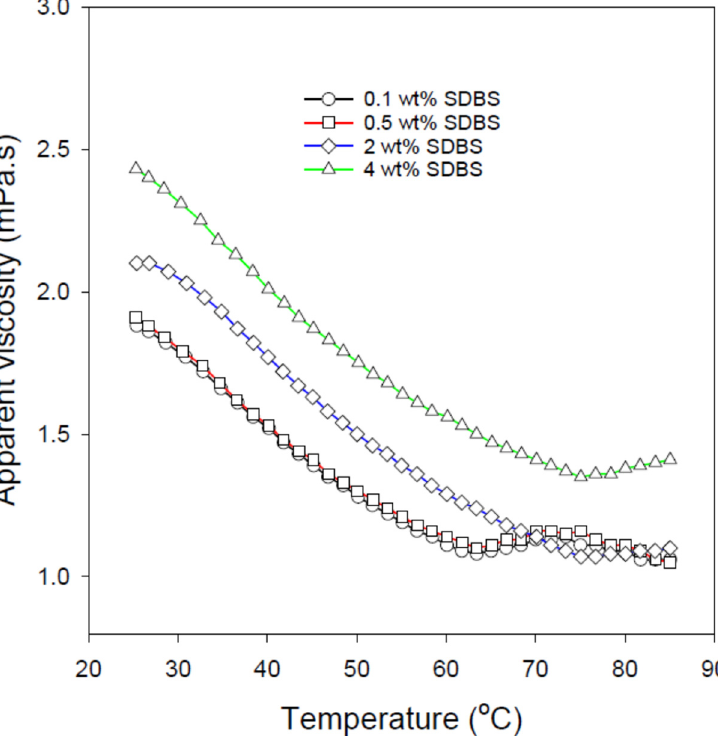
Figure 5. The effect of temperature on the apparent viscosity of the formulated O/W nanoemulsions using different SDBS concentrations. These measurements were conducted at 100 s − 1 shear rate.